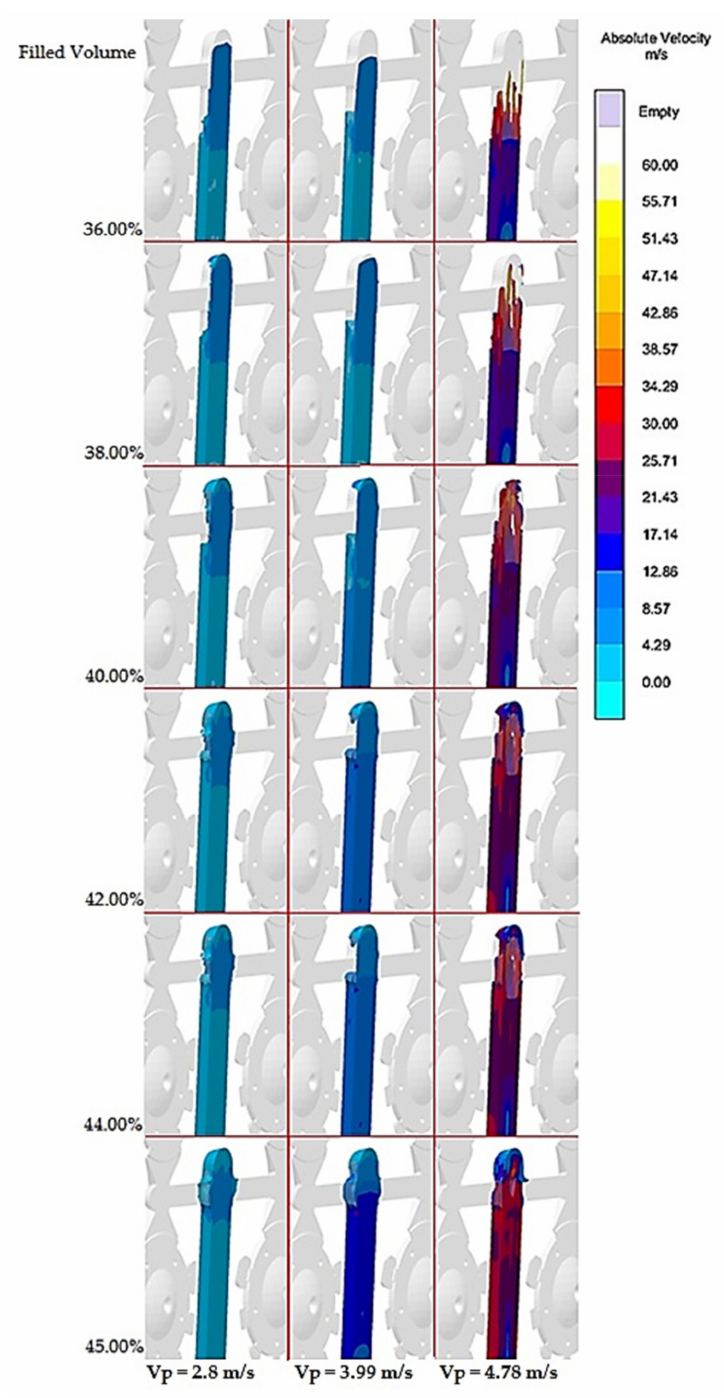
Figure 6. Gas entrapment by the melt in the runner in the area of runner